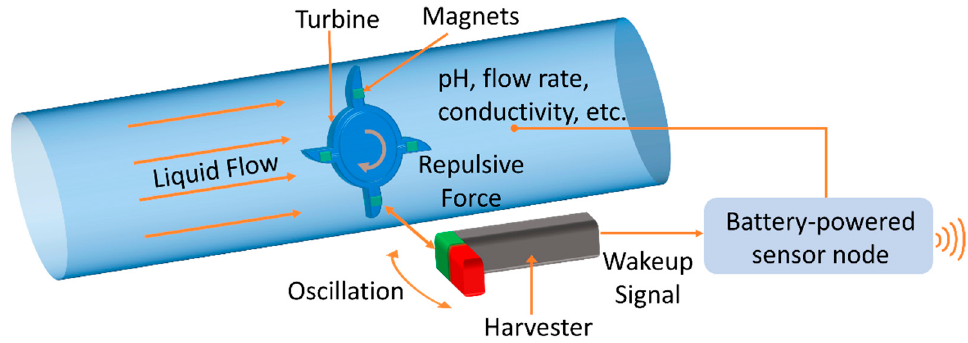
Figure 1. Application scenario of a magnetic MEMS-based wakeup device for a water monitoring system. A low-frequency rotary motion triggers the wakeup of a battery-powered WSN in a contactless way.